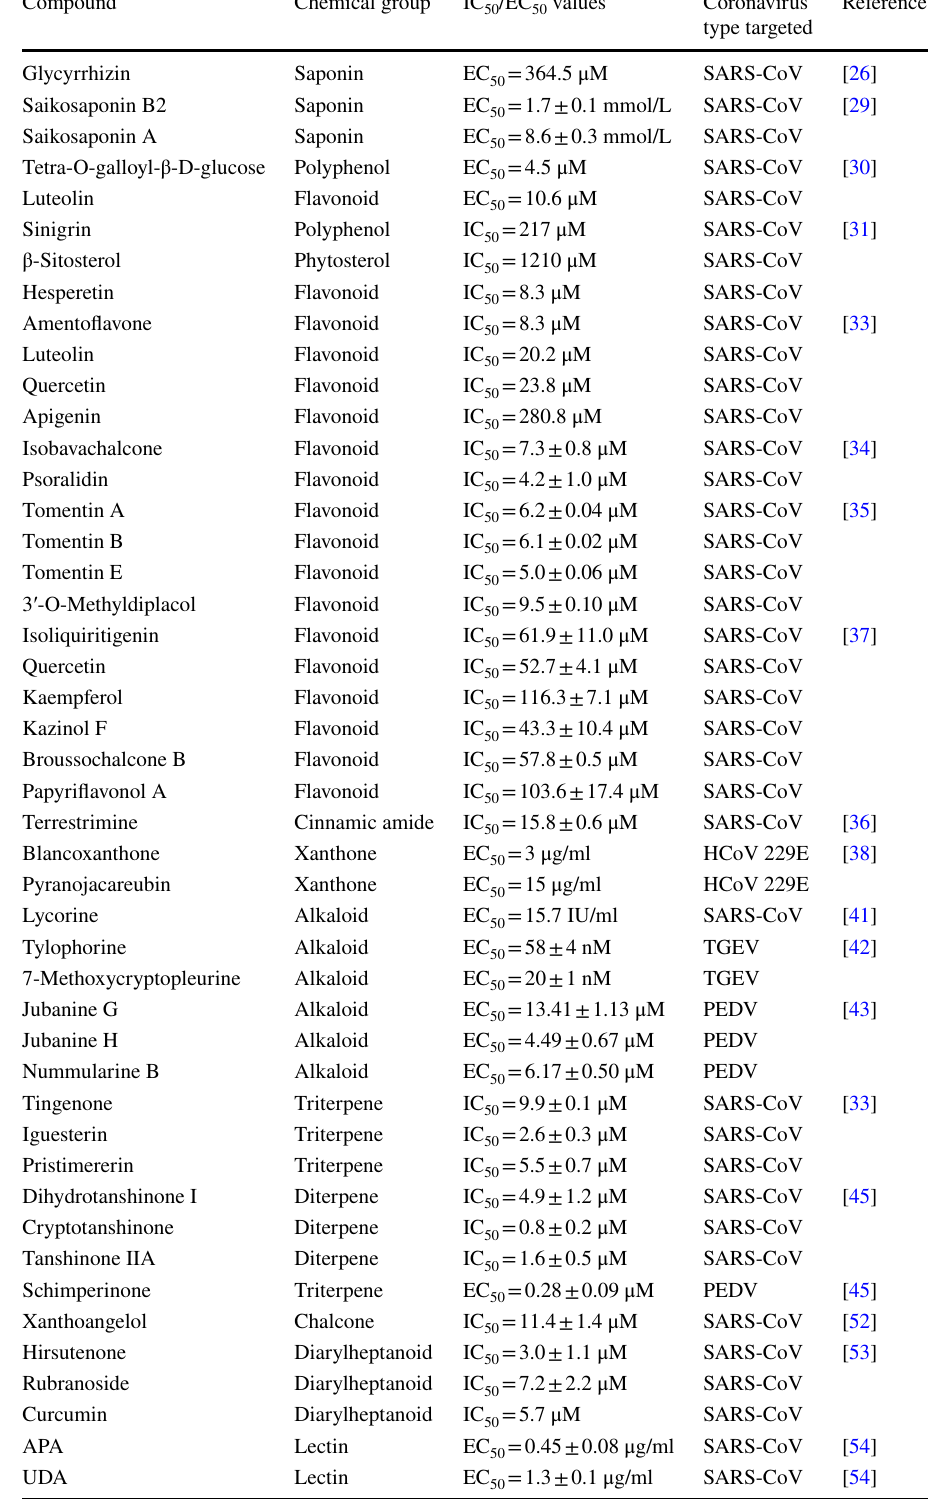
Table 1 Examples of some promising natural molecules with coronavirus inhibitory